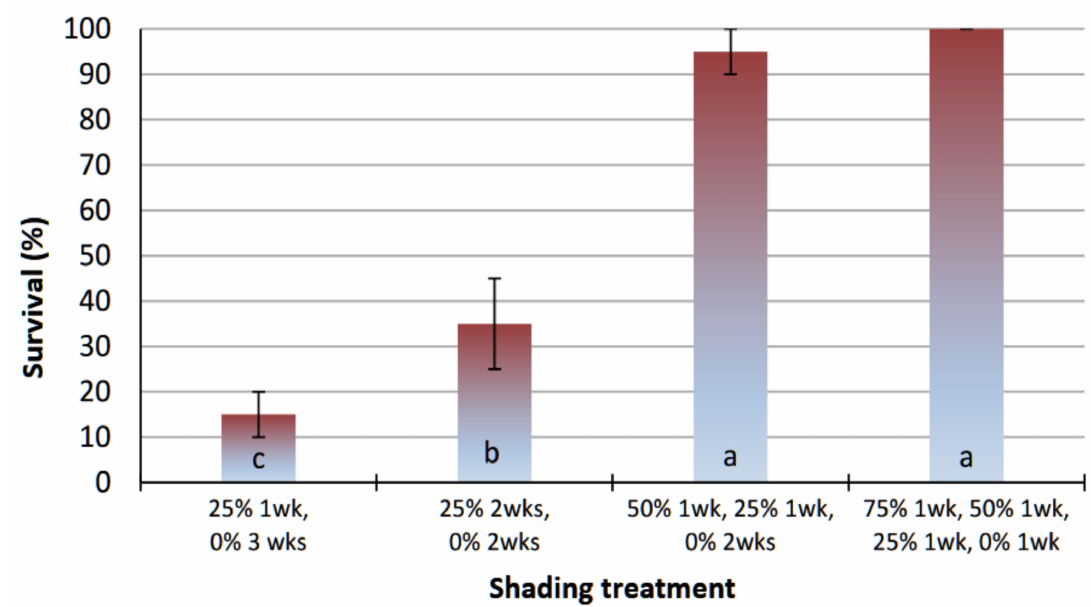
Figure 4. Effect of different shading treatments during acclimatization of in vitro-produced plantlets of G. jasminoides, derived from regenerant shoots of encapsulated shoot tip explants which had stored at 4 ◦ C for 12 weeks, on their survival rate. Bars represent the means ± SD ( n = 45). Bars with different letters are significantly different according to Duncan’s multiple range test at p ≤